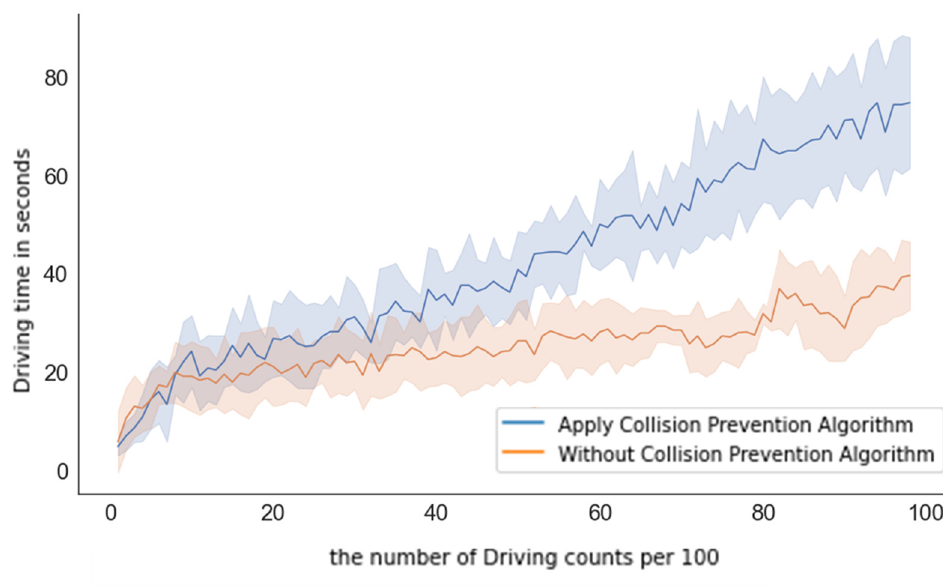
Figure 9. The results of models with and without the application of the collision protection algorithm. (Mean and standard deviation of 5 training simulations).